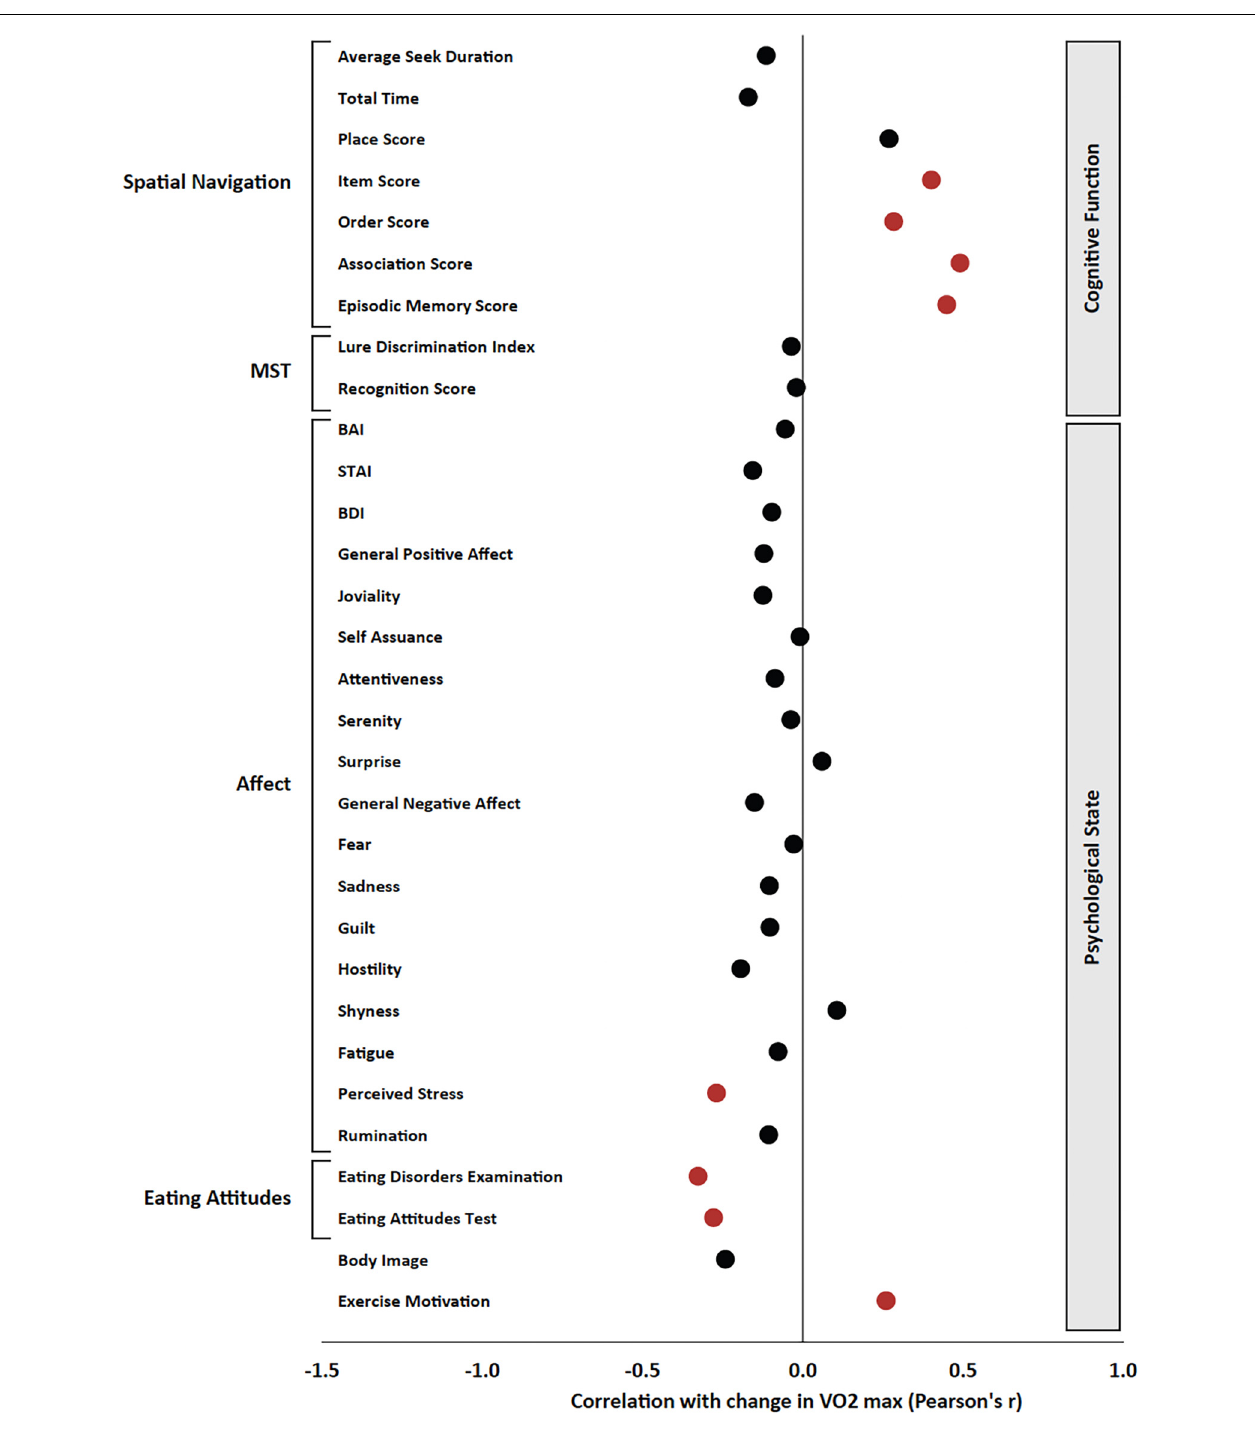
FIGURE 5 | Pearson’s product-moment correlation between the change in estimated VO 2 max and all variables of interest. Pearson’s r is presented on the x axis, and significant effects ( p < 0.05) are presented in red; non-significant effects are presented in black.